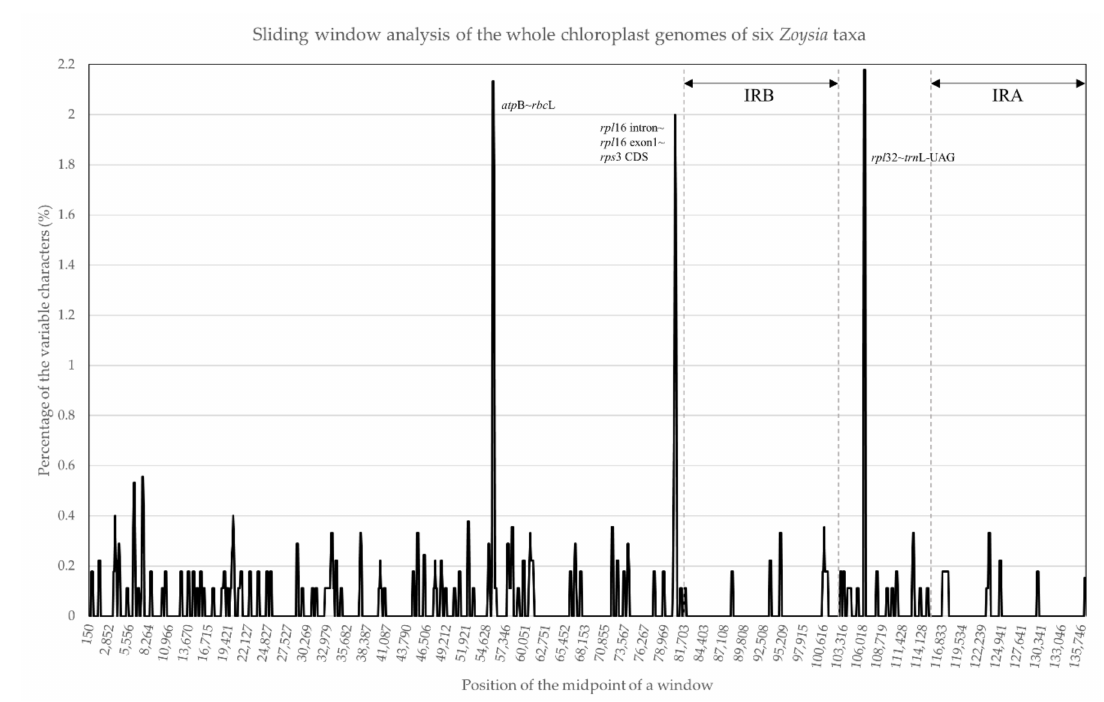
Figure 3. Sliding window analysis of the whole plastomes of six Zoysia species. The x -axis represents the midpoint position of a window, and the y -axis represents the nucleotide diversity of each window. Three noncoding regions ( atpB~rbcL, rpl16~rps3 , and rpl32~trnL-UAG ) show more than 2% sequence divergences among the six Zoysia species.